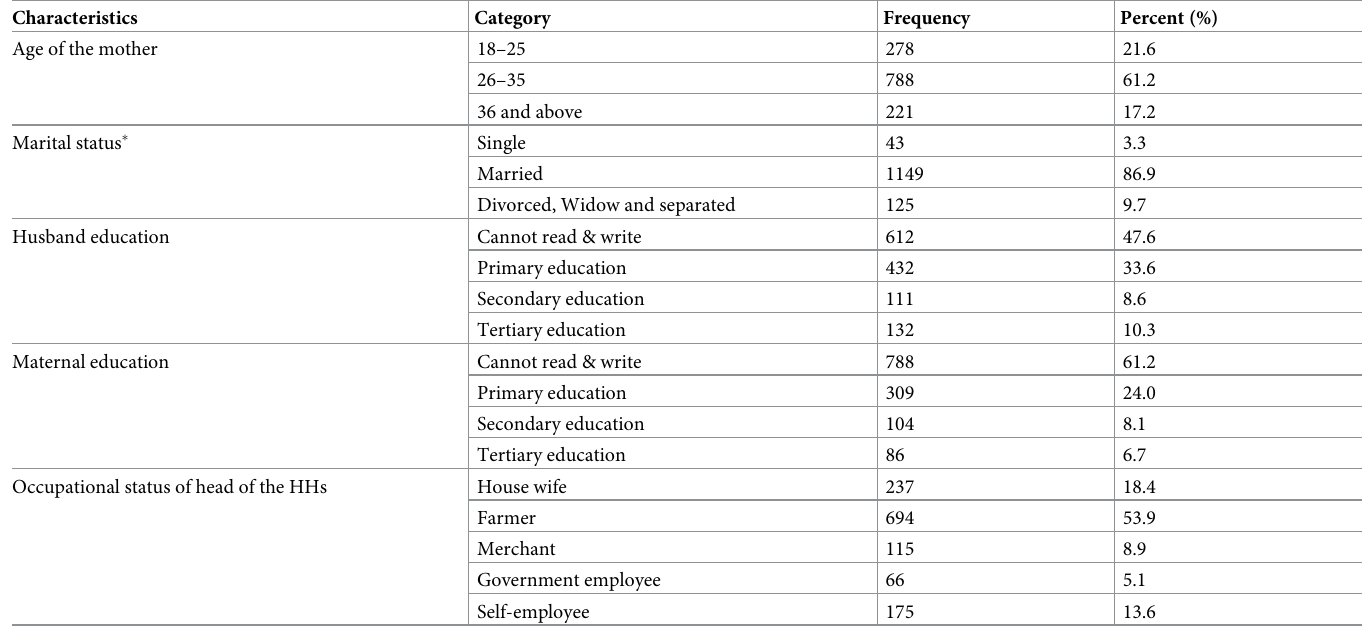
Table 1. Demograpic and socio-economic characteristics of parents in Libo-kemekem district, northwest Ethiopia. Characteristics